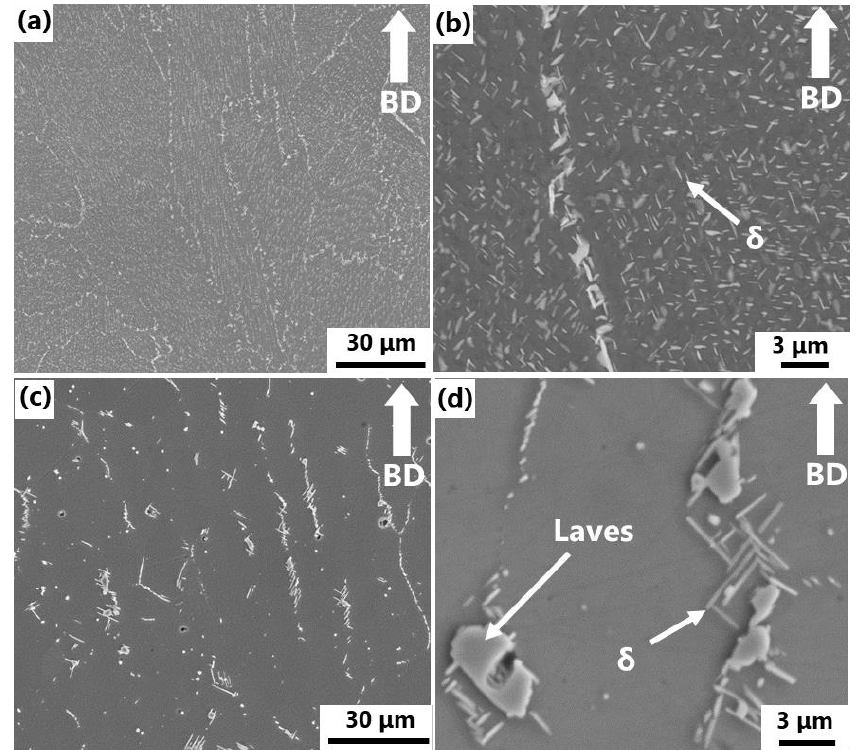
Figure 4. Microstructure of the heat-treated (HT) specimens: ( a , b ) for the Ar-SLM and ( c , d ) for the V-SLM.